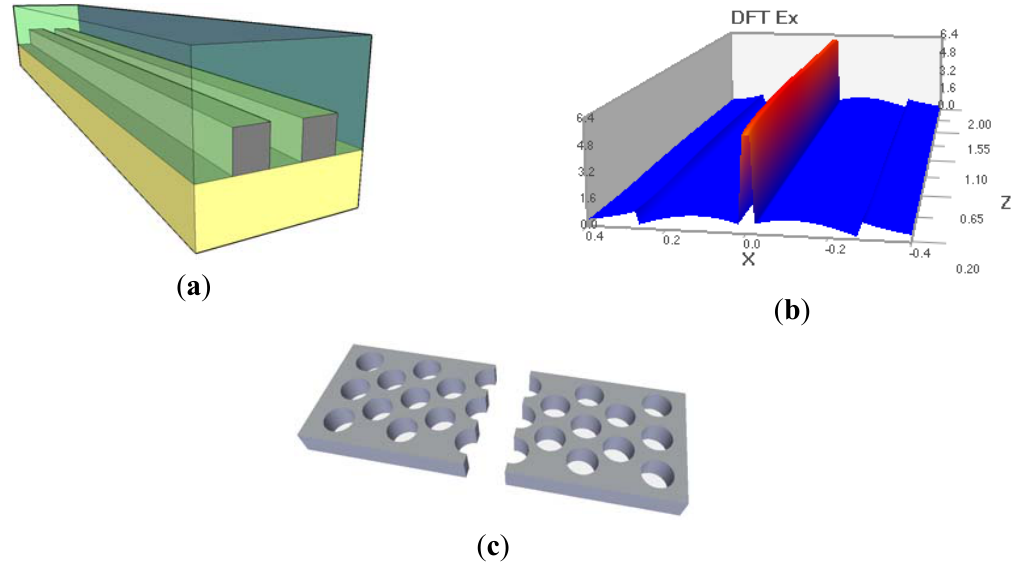
Figure 6. ( a ) Schematic view of a slot waveguide (oxide cladding shown in yellow, silicon slot–in gray, EO polymer cladding–in green); ( b ) mode profile supported by a silicon slot waveguide; ( c ) schematic of a photonic crystal slot